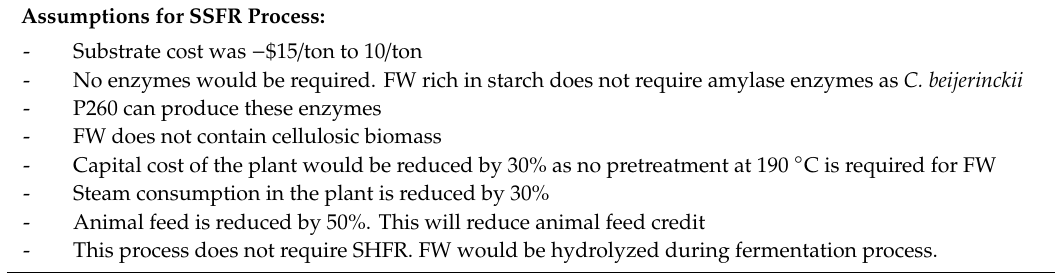
Table 3. Assumptions and butanol selling price for food waste (FW) to butanol process.